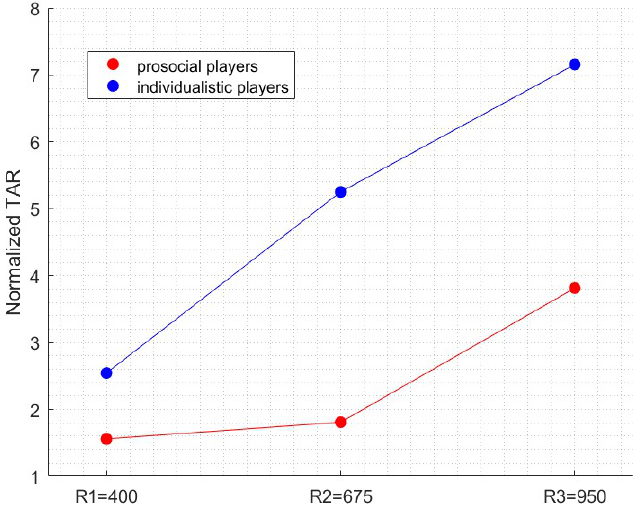
Figure 8. The interaction between SVO category and radius size for normalized TAR.